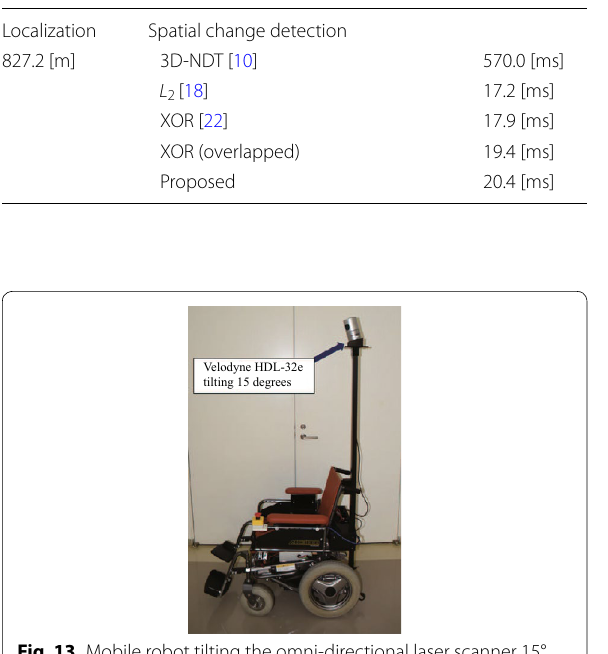
Fig. 13 Mobile robot tilting the omni-directional laser scanner 15°